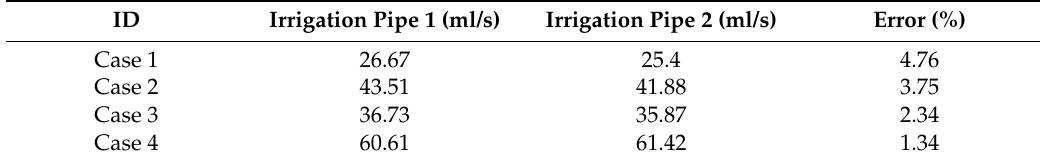
Table 6. Flow rate of each irrigation pipe.